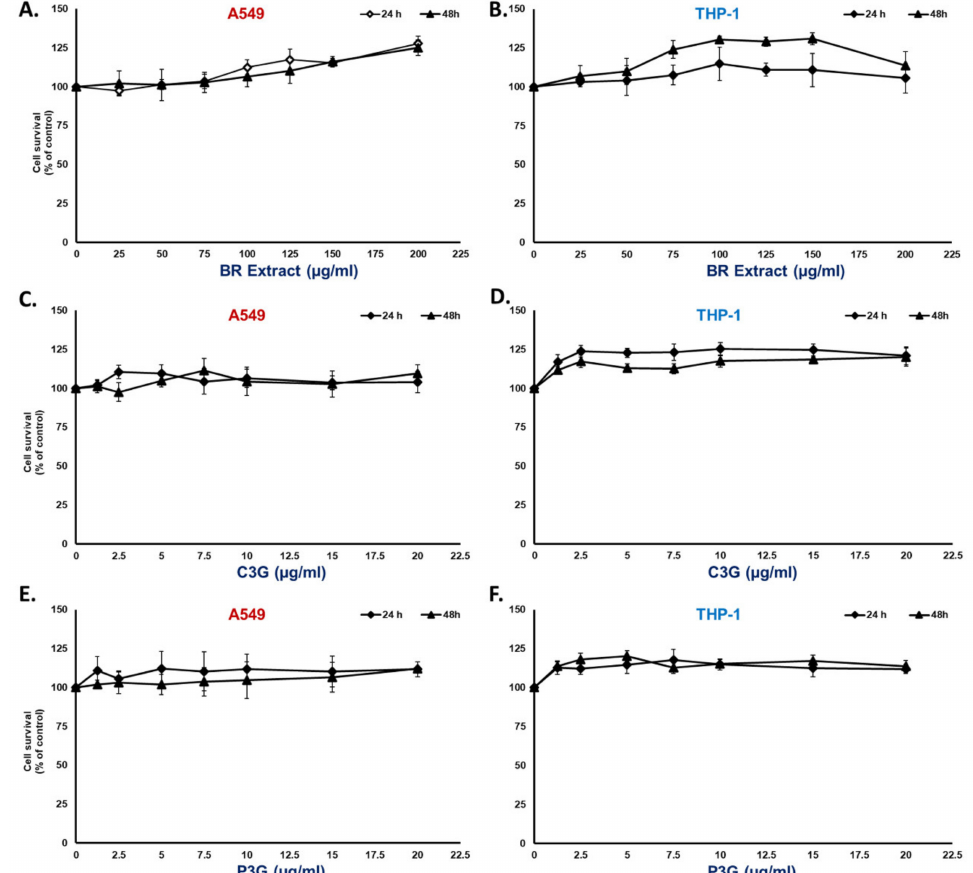
Figure 2. Cytotoxicity profile of BR extract and its active compounds on A549 lung cells and differentiated THP-1 macrophages. A549 (at 3 × 10 3 cell/well) and PMA-treated THP-1 macrophage (6.5 × 10 3 cell/well) were treated with BR extract at the concentration of 0–200 µ g/mL ( A , B ), or the active compound; C3G ( C , D ); and P3G ( E , F ) at the concentration of 0–20 µ g/mL for 24 h and 48 h. Cell viability was determined using MTT assay. Data are presented as mean ± S.D. values of at least three independent experiments. PMA, phorbol 12-myristate 13-acetate; MTT, 3-(4,5-dimethylthiazol- 2-yl)-2,5-diphenyltetrazolium